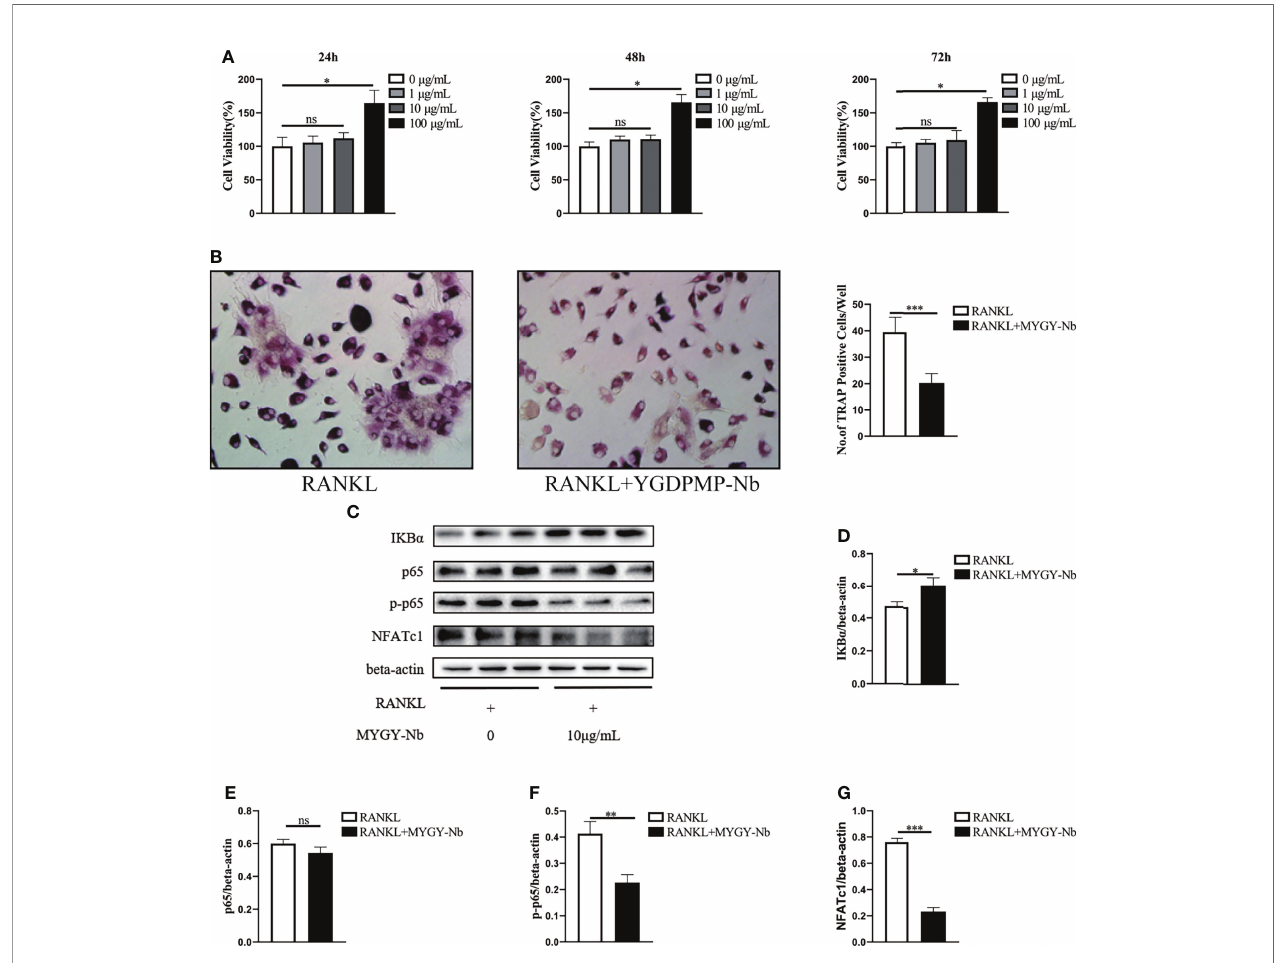
FIGURE 6 | The effect of MYGY-Nb on RANKL-induced osteoclast formation. (A) Cell viability of BMMs cultured with various concentrations of MYGY-Nb for 24 h, 48h and 72 h. (B) Formation and quanti fi cation of TRAP-positive cells from BMMs. (C – G) Effects of MYGY-Nb on the activation of the NF- k B signaling pathway in RANKL-induced BMMs. Data are presented as mean±S.D. (n=3), * P < 0.05; ** P < 0.01; *** P < 0.001; ns, no signi fi cant difference, as compared to group treated with RANKL, n = 3 in each